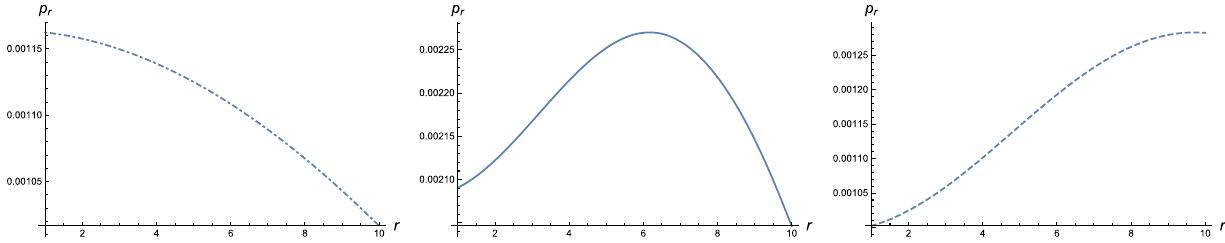
Fig. 2 Plots of the radial pressure evolution of the strange star candidates Her X-1, SAX J 1808.4-3658, and 4U 1820-30; represented by (left to right) the first, second, and third graphs,